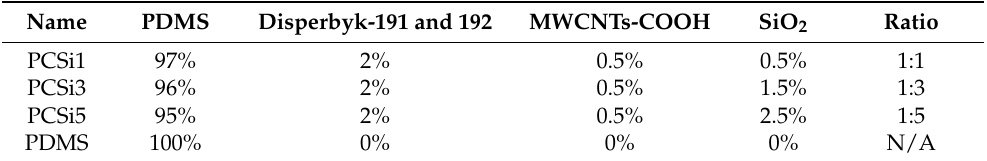
Table 1. The compositions of different